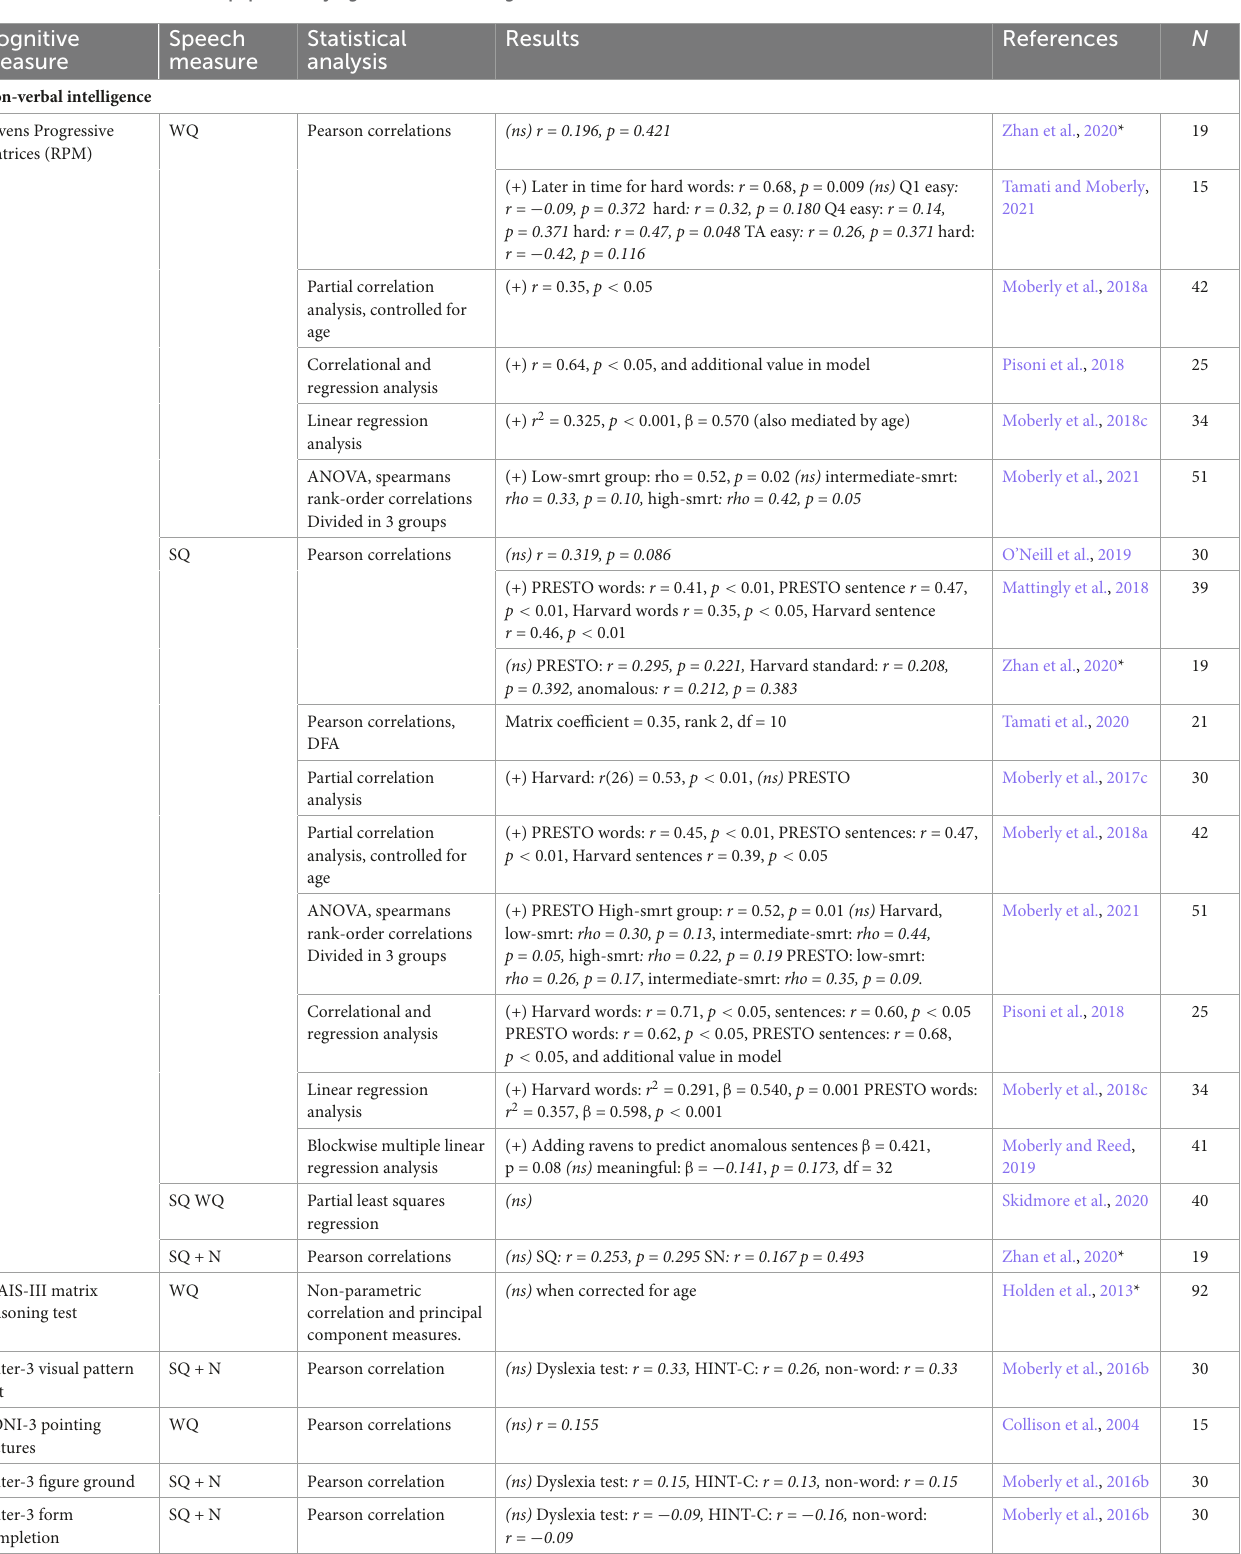
TABLE 6 Overview of included papers studying non-verbal